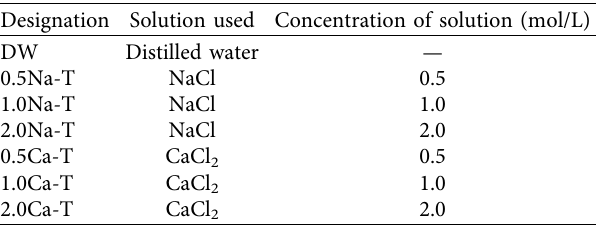
Table 2: Designations of specimens prepared with different solution.